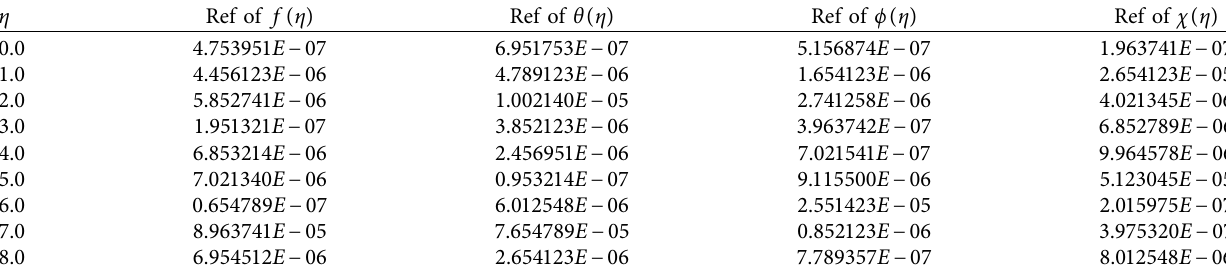
Figure 11: (a) Impact of ε Table 2: Values for the REF in the current method.